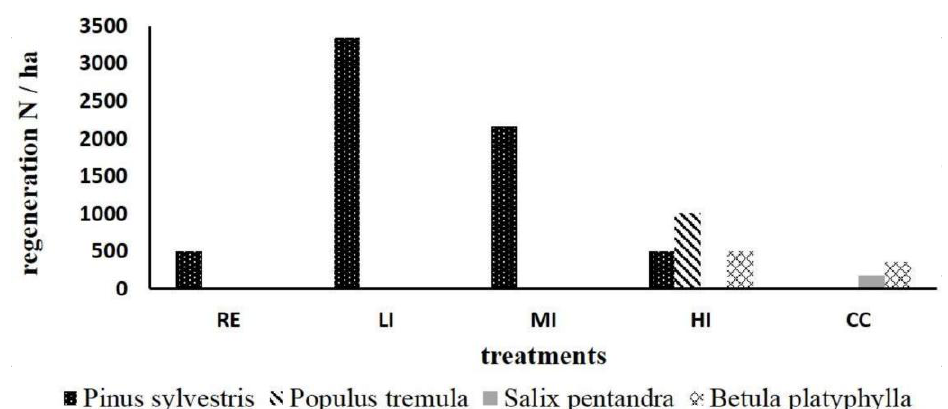
Figure 6. Assessed regeneration density (height > 15 cm and diameter at breast height (DBH) < 6 cm; N/ha) of the different treatments in 2017. When considering only treatments with removal (LI-CC) the trend is almost linear negative.